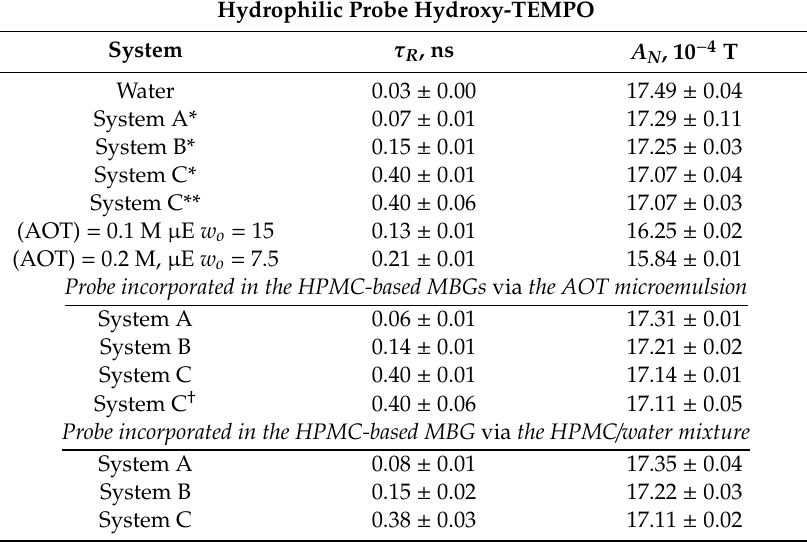
Table 2. τ R and A N values of hydrophilic spin-probe Hydroxy-TEMPO in water, AOT microemulsions, and HPMC-based MBGs